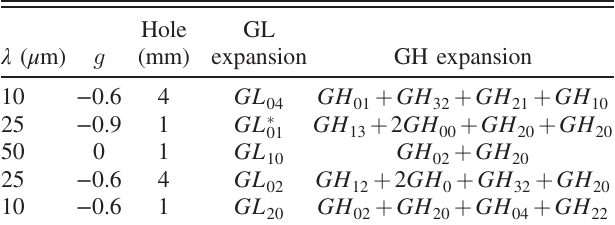
TABLE II. Mode profiles characterized in terms of GH and GL expansions.